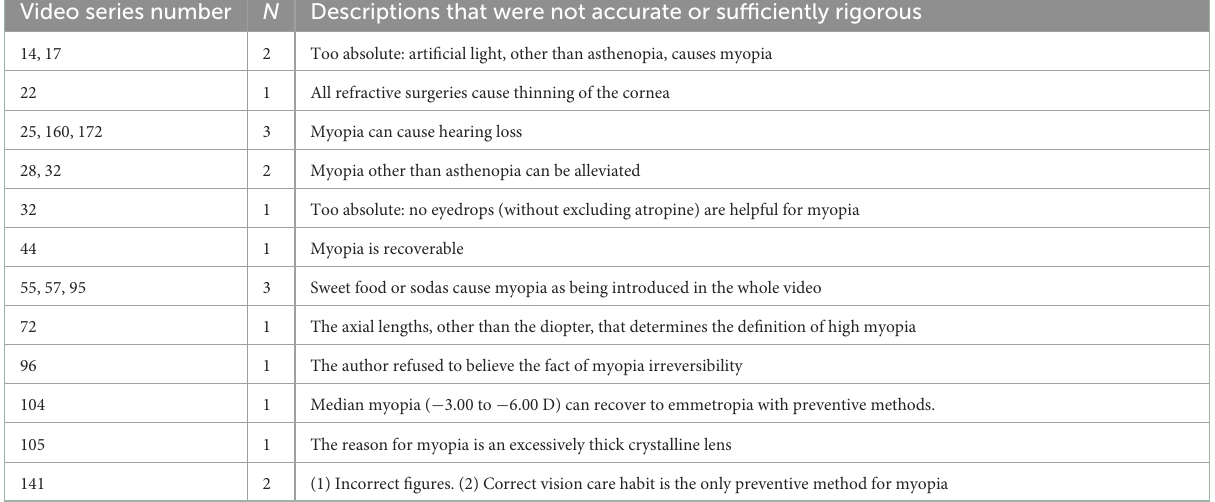
TABLE 2 Misinformation categorized by video numbers. Video series